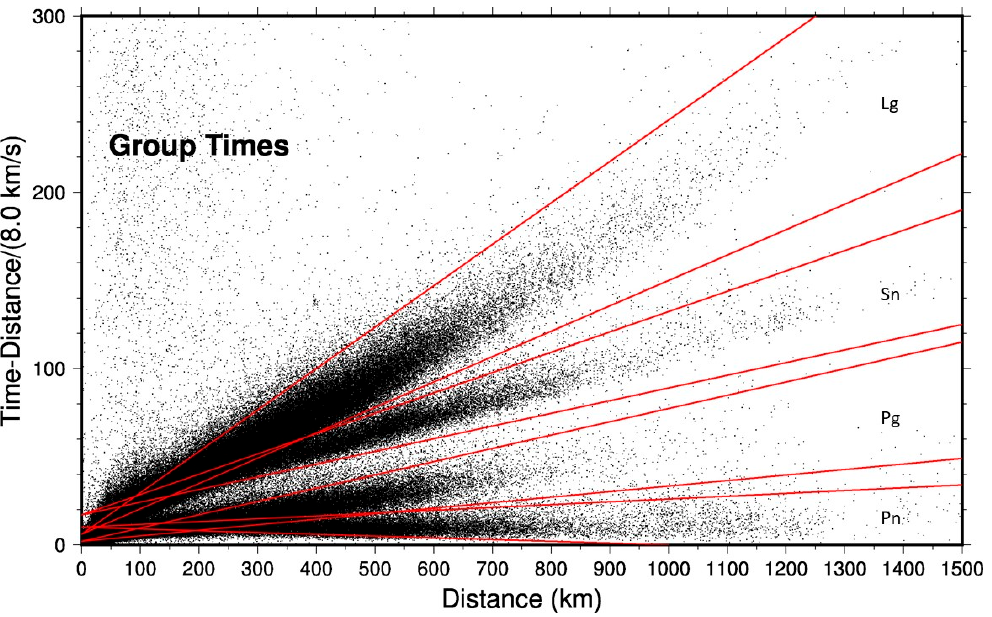
Figure 2. Group travel times. Four phases are recognized and winnowed by the corresponding sec- tors.